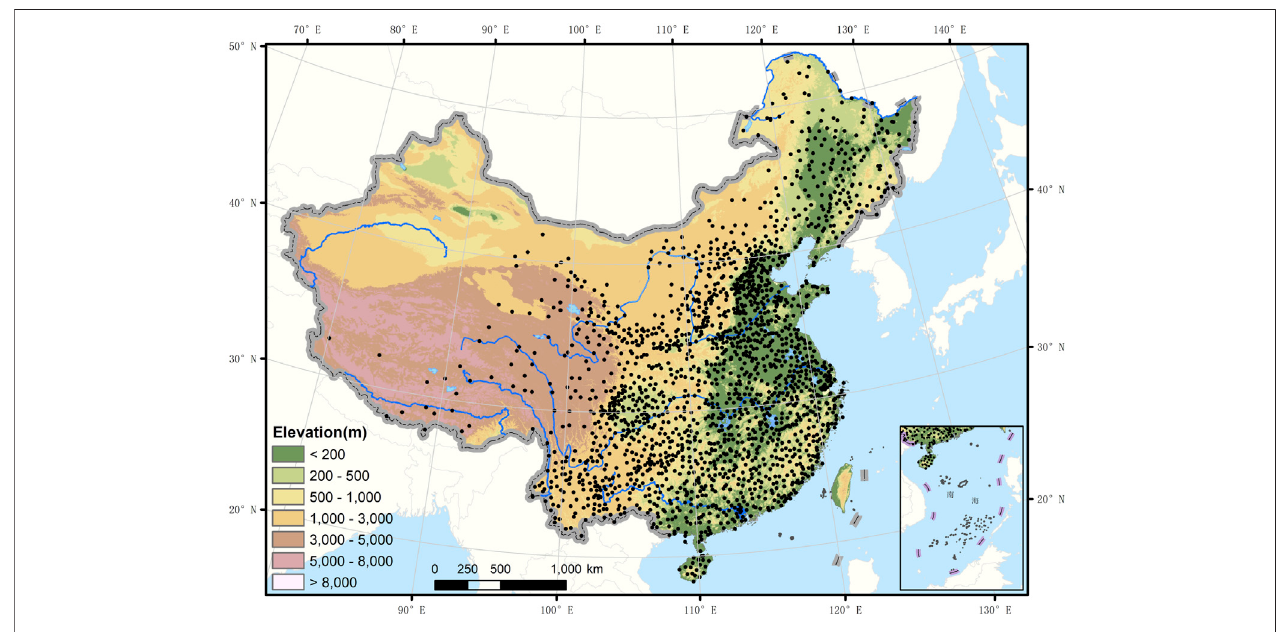
FIGURE 1 | Study area and station